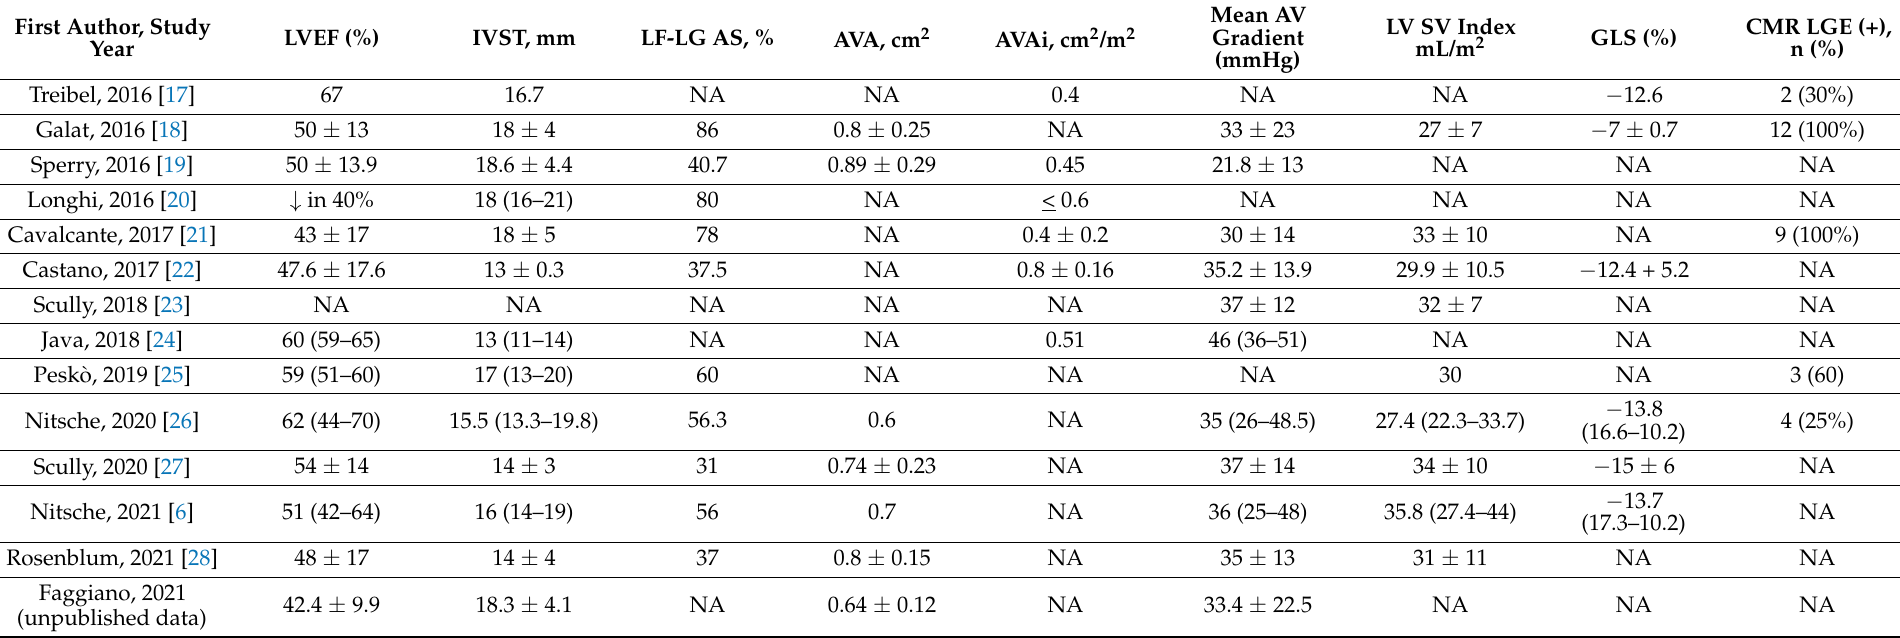
Table 4. Imaging parameters of aortic stenosis-cardiac amyloidosis patients. See the text for